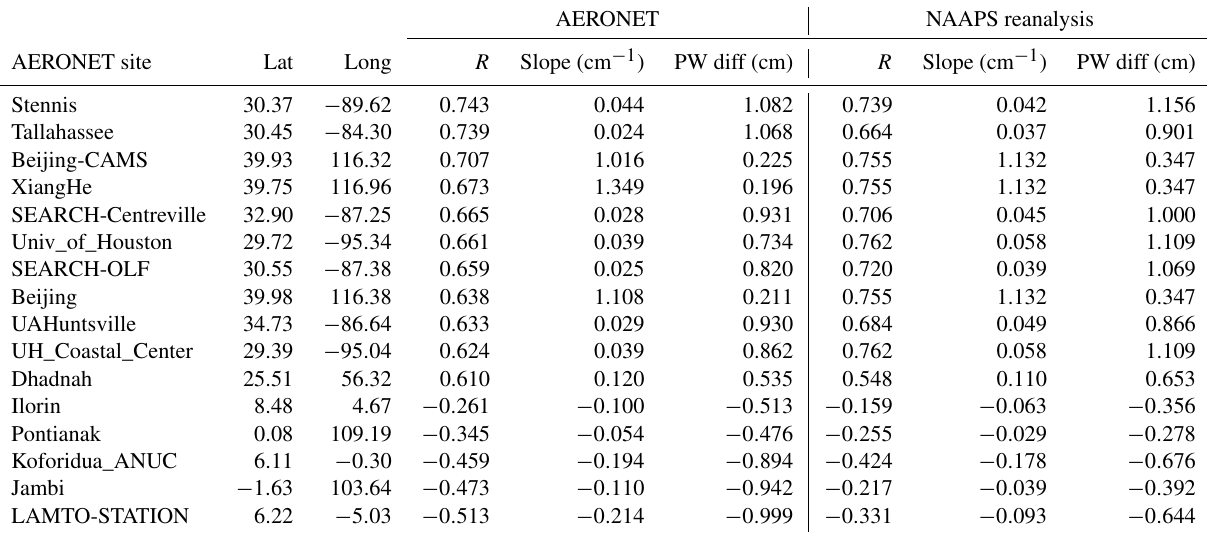
Table 1. AOD and PW relationship evaluation results for DJF at select AERONET sites that exhibited the strongest AERONET correlations, positive and negative. The site name and latitude–longitude information are shown, as well as the correlation ( R ), the change in AOD with PW (slope), and the statistically significant difference in mean PW for high-AOD events (PW diff) for both AERONET and the NAAPS-RA.